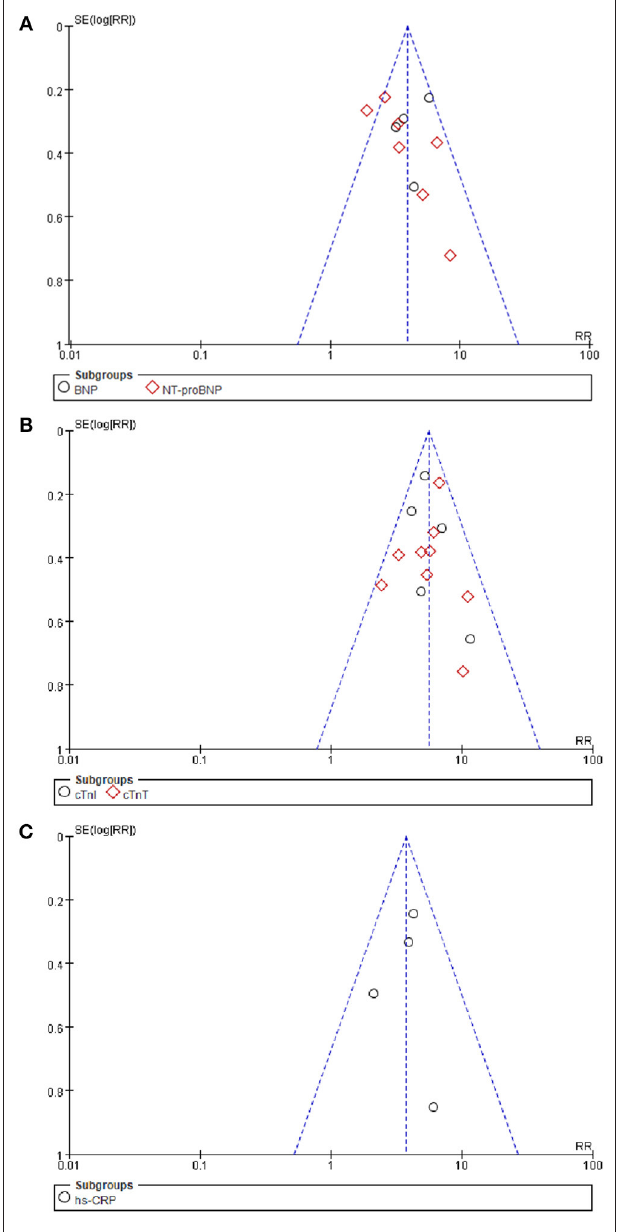
FIGURE 7 | (A–C) Begg’s funnel plot with pseudo 95% confidence